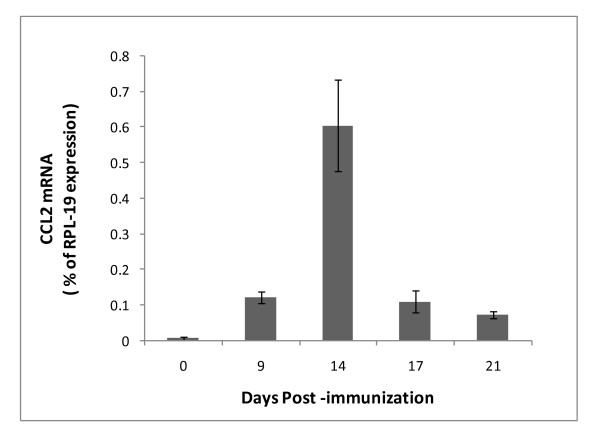
CCL2 expression profile during experimental autoimmune encephalomyelitis (EAE). Mice were immunized with MOG peptide to induce EAE. At the indicated days post-immunization, mice were sacrificed and CCL2 mRNA levels determined in the whole brain. CCL2 expression is seen to rapidly rise and fall between days 9 to 21, showing the highest level at day 14.